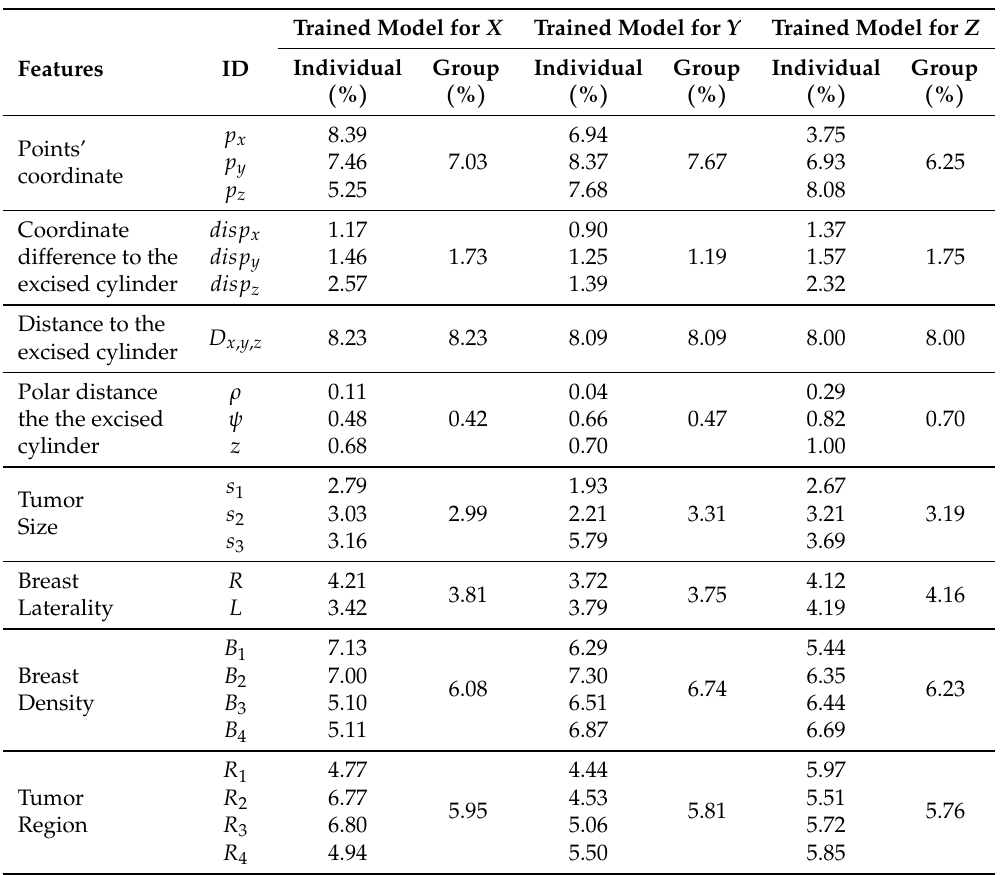
Features’ importance (both individual and grouped) measured in % for RF with adaptive